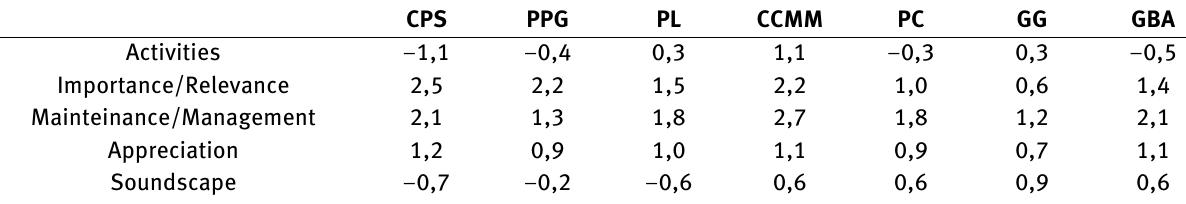
Table 5: Semantic Differential Scale Results